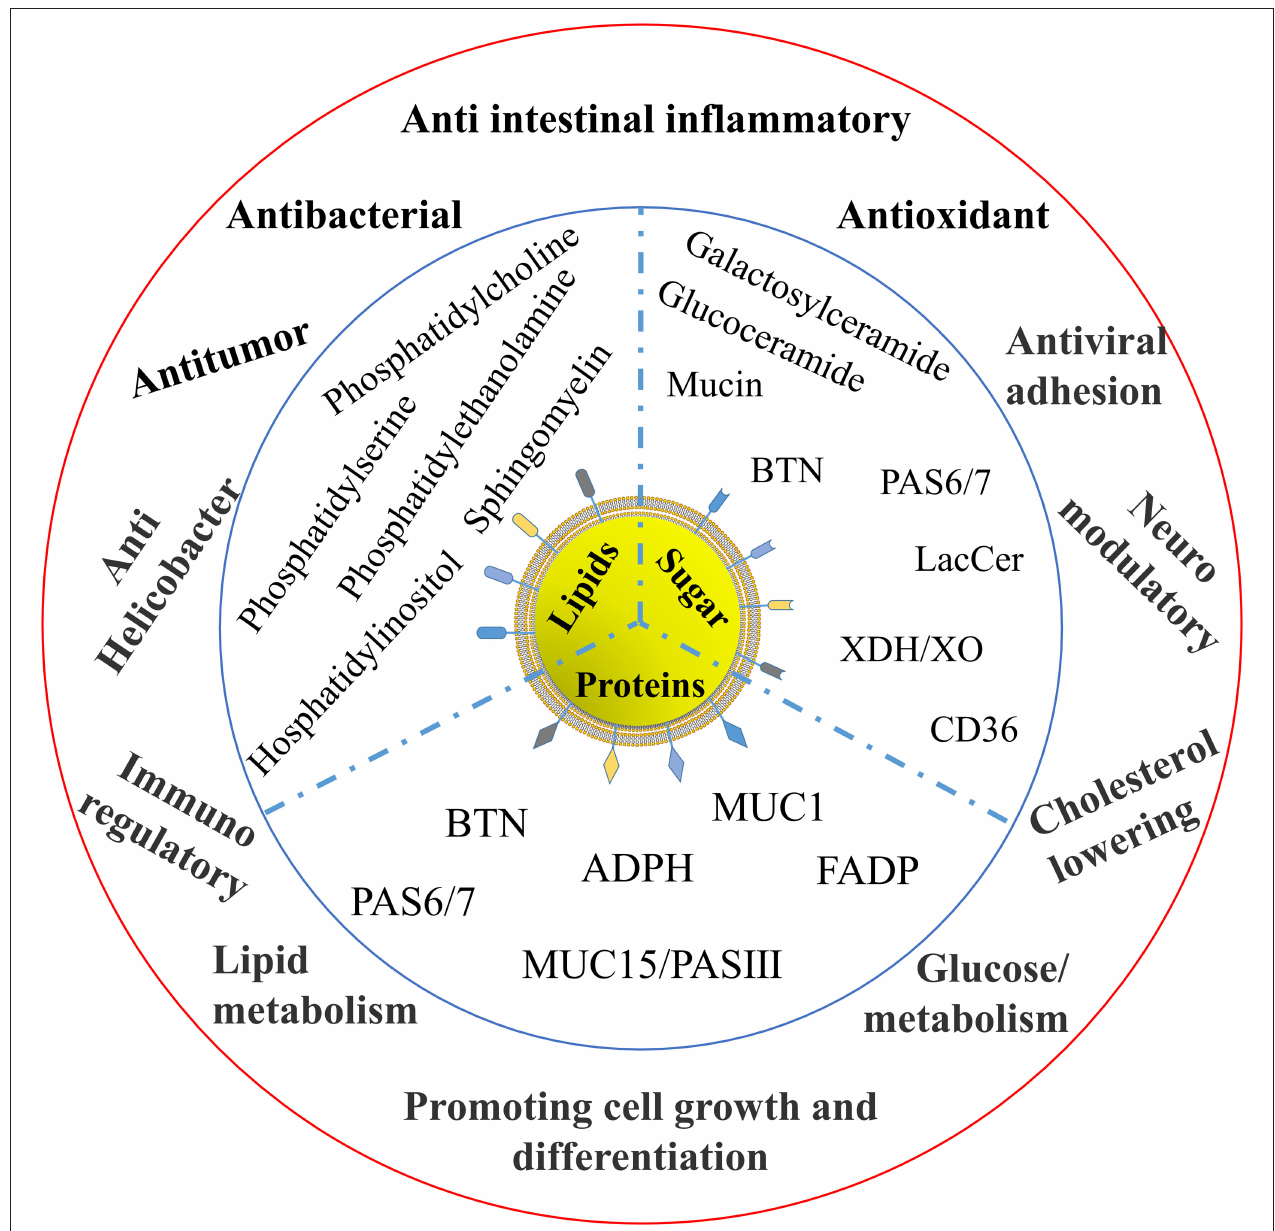
FIGURE 3 | Bioactivities of the components in